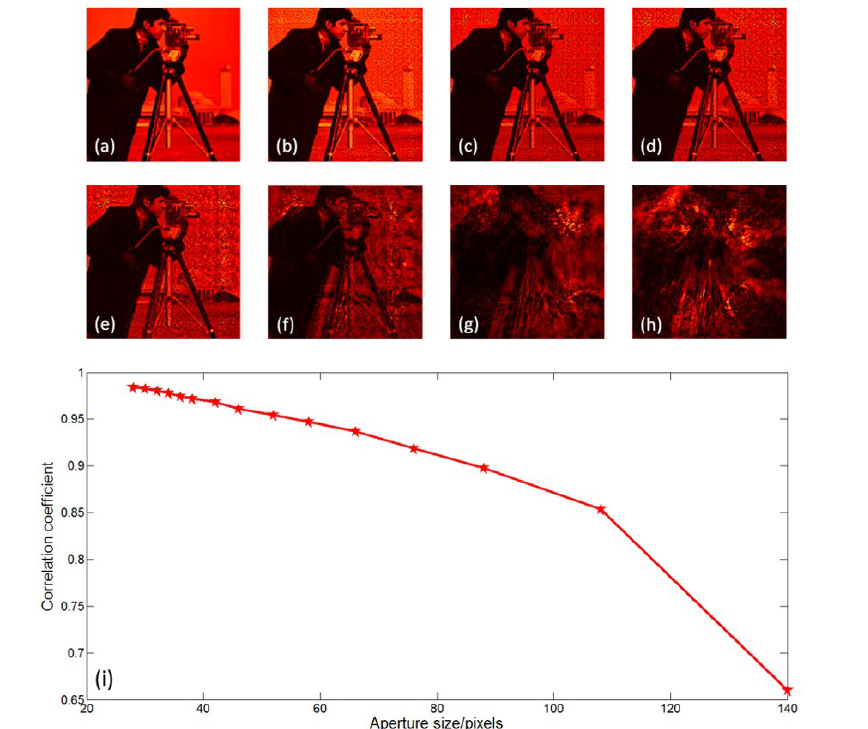
Figure 6. Effect of the diameter of the probe beam to the reconstruction performance. ( a ) The target, ( b ) 28 pixels, ( c ) 32 pixels, ( d ) 36 pixels, ( e ) 46 pixels, ( f ) 76 pixels, ( g ) 108 pixels, and ( h ) 140 pixels. ( i ) The correlation coefficient against a different aperture